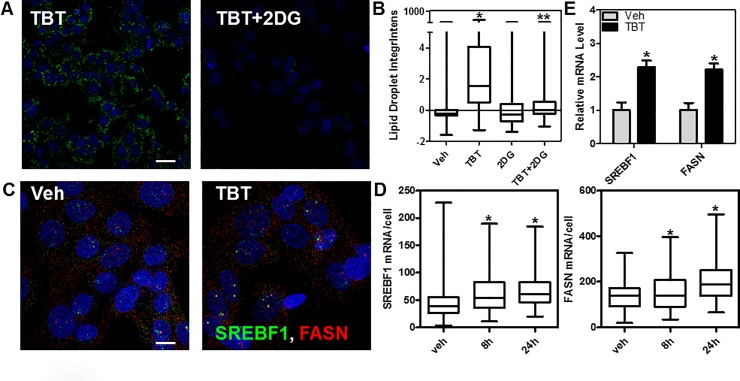
TBT increase in lipid droplets is mediated through glycolysis and activation of some lipogenic genes.A) HepaRG cells were grown in the presence of TBT (50 nM), 2-deoxyglucose (2DG, 2 mM) or vehicle for 3 days, then lipid content was analyzed as in Fig 1. Representative 40x images are shown. Scale bar: 25μm. B) quantification of images from the experiment performed in panel A, data is z-normalized based on vehicle (DMSO) treatment and shown as integrated intensity of lipid droplets/cell. *p<0.01 compared to Vehicle; **p<0.01 compared to TBT. C-D) Single molecule RNA FISH for SREBF1 and FASN was performed in HepaRG cells after 8 and 24 h (shown in the panels) of TBT or vehicle treatment. Images (60x/1.4NA) shown are max projections after deconvolution. In panel D, the number of single RNA molecules/cell was counted and represented as a box plot. Scale bar: 10 μmM. E) RT-qPCR validation of TBT induction of SREBF1 and FASN mRNAs after 24h of 50nM TBT treatment. *p<0.01 compared to Vehicle.